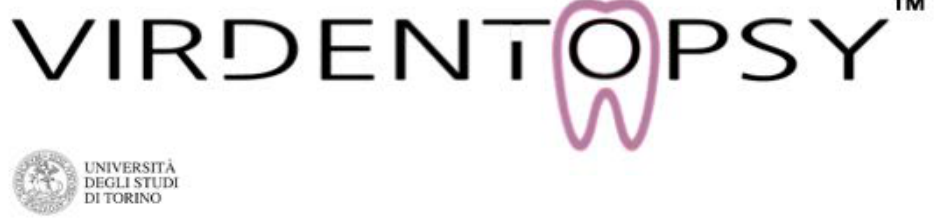
Figure 1. Virdentopsy™ registered brand (Class